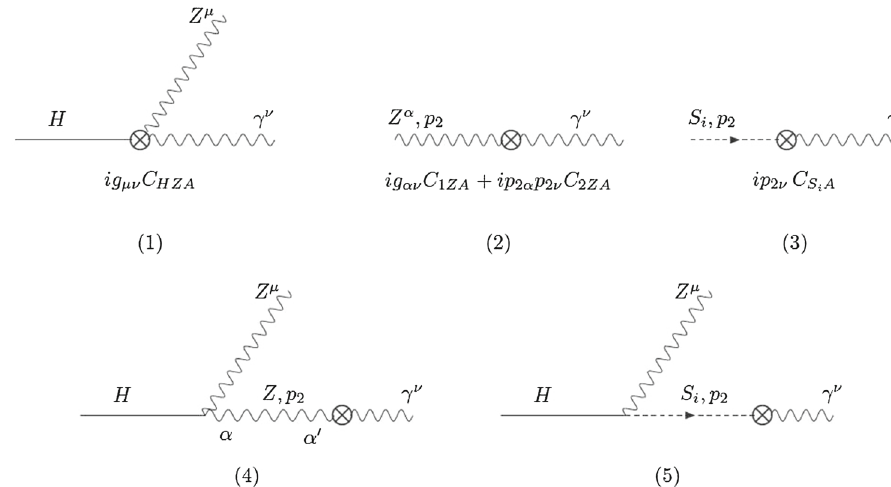
Fig. 2 Counterterm vertices and related one-loop diagrams contributing to the one-loop amplitude of the decay h → Z